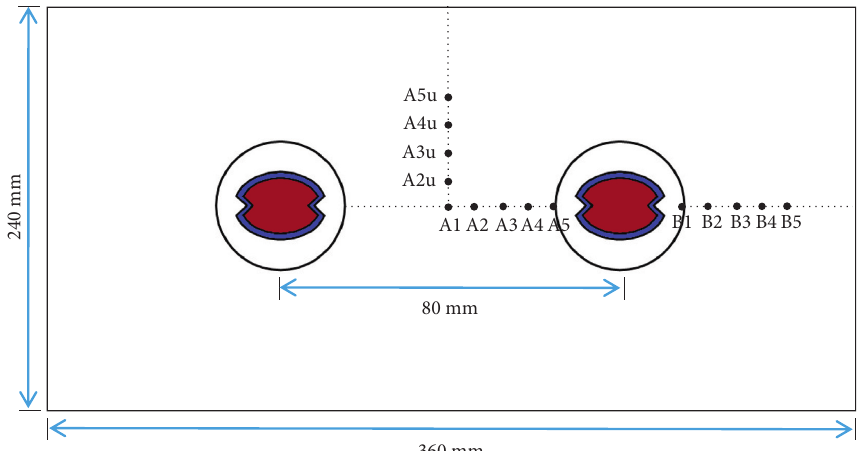
Figure 6: Schematic diagram of the numerical calculation model for the ordinary blasting model for shaped charge blasting.